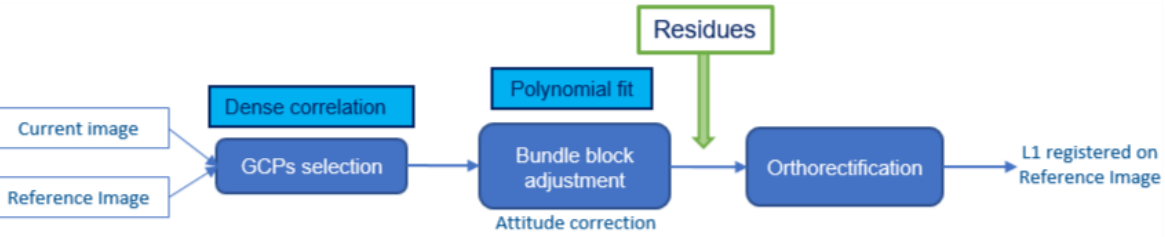
Figure 22. Reminder of L1 geometric correction processing and assessment of registration residues.